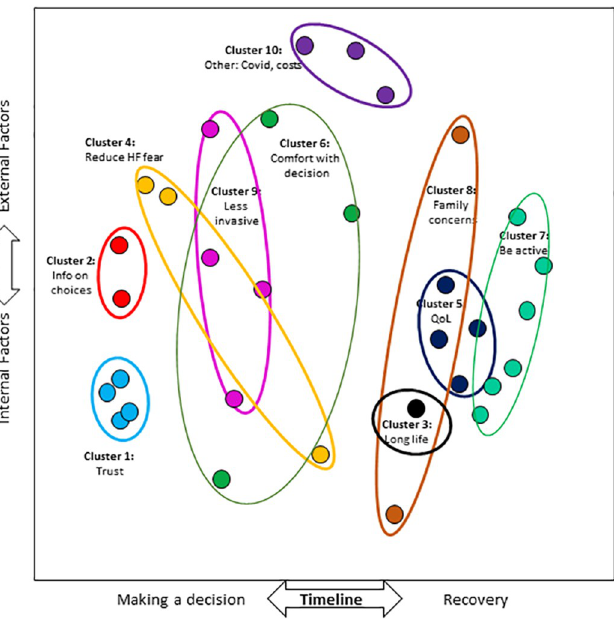
Fig 2. Cognitive map of patient treatment goals. Each cluster identifies how specific treatment goals identified using the nominal group technique were grouped and labeled by a group of 38 patients during card sorting activities. Multidimensional scaling defined the spatial orientation of each specific goal and hierarchical cluster analysis guided the identification of the clusters. HF denotes heart failure. Info denotes information. QoL denotes quality of life.